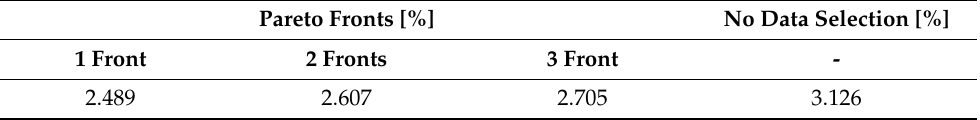
Table 8. MAPE values for Pareto fronts and ‘no data selection’ models for the fourth verification case. Pareto Fronts [%] No Data Selection [%]